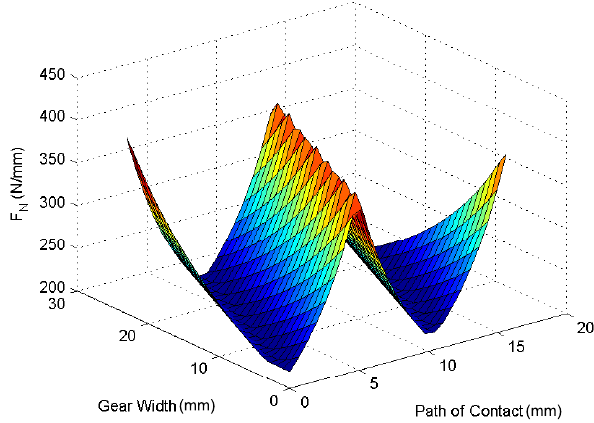
Figure 1. Load distribution of a helical gear with an applied torque of